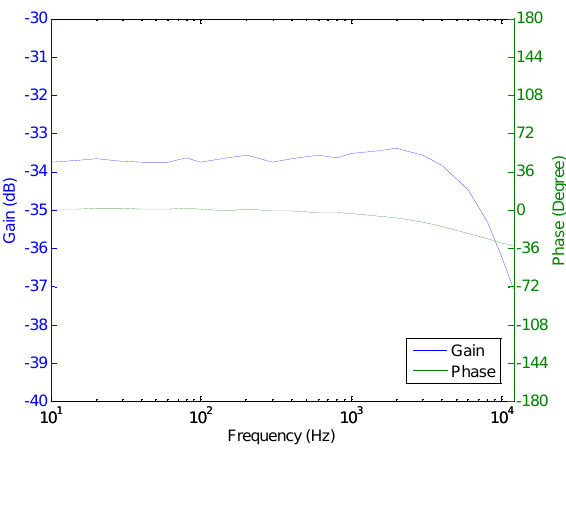
Figure 14. Frequency response of the improved